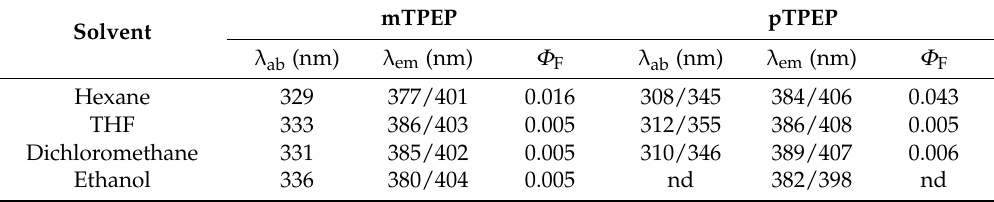
Table 1. Optical transition of two TPEP derivatives in different solvents.